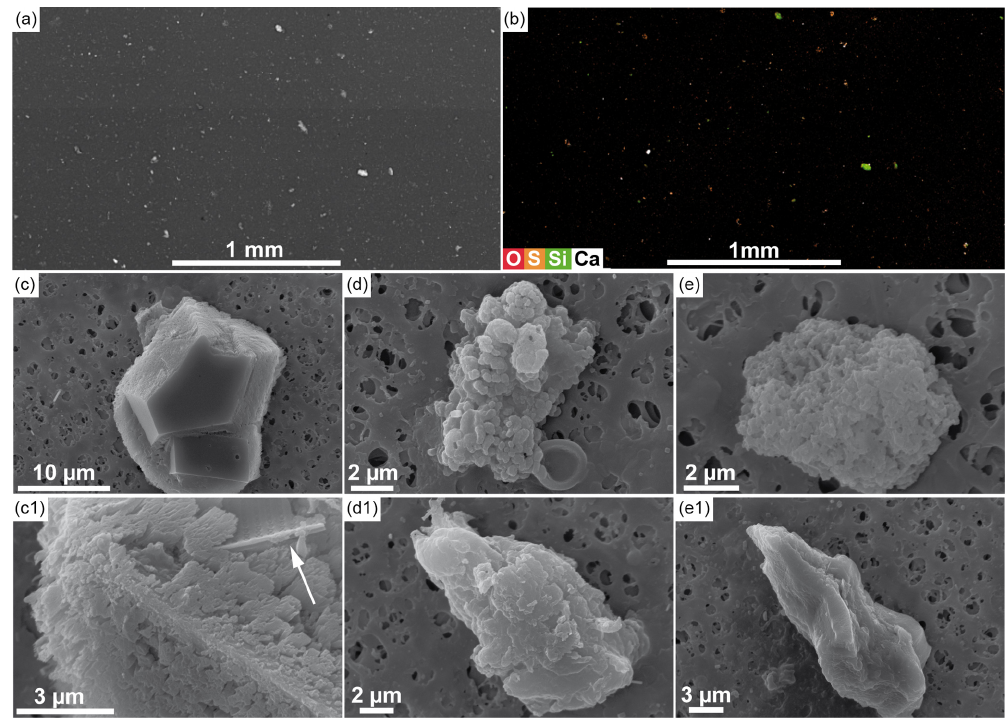
Figure 7. SEM analysis of turbid layer filtrate. Various particles on the filter are visible on the SEM picture of a larger area of the filter (a) . An element map for O, S, Si and Ca of the same filter area of (a) is shown in (b) revealing that most particles consist of elemental sulfur, calcium-rich particles and silica particles. EDX analysis of individual particles on the filter verified the particles as calcium carbonates (c, c1) , elemental sulfur (d, d1) and silicate phases (e, e1) . The white arrow in c1 points to a fragmentary silica shell.